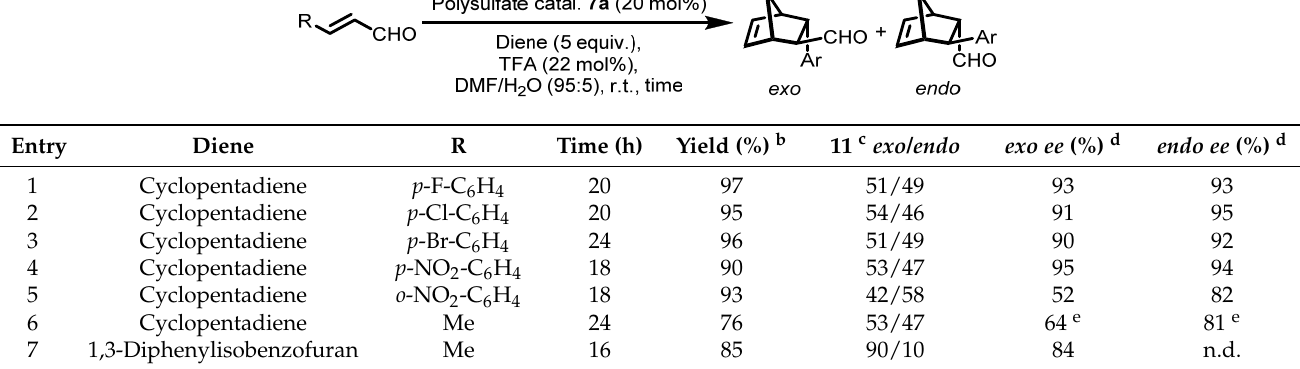
Table 6. Substrate scope of the asymmetric Diels–Alder reaction with chiral polysulfate organocatalyst 7a a .